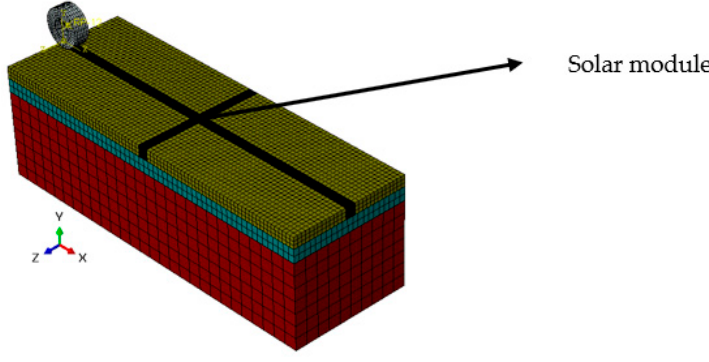
Figure 6. Meshed FE model assembly.